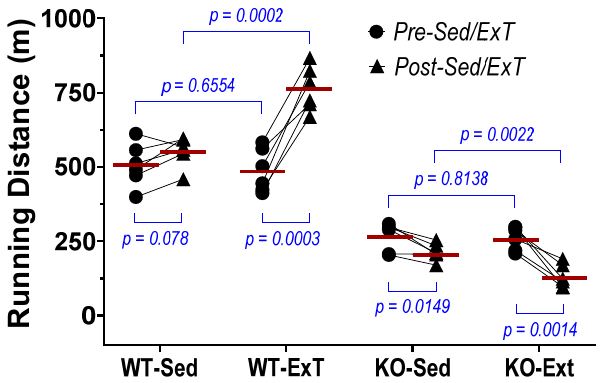
Figure 1. Effects of ExT on exercise performance of mice with SkM-Nrf2 intact (WT) and deleted (KO). n = 6/group.